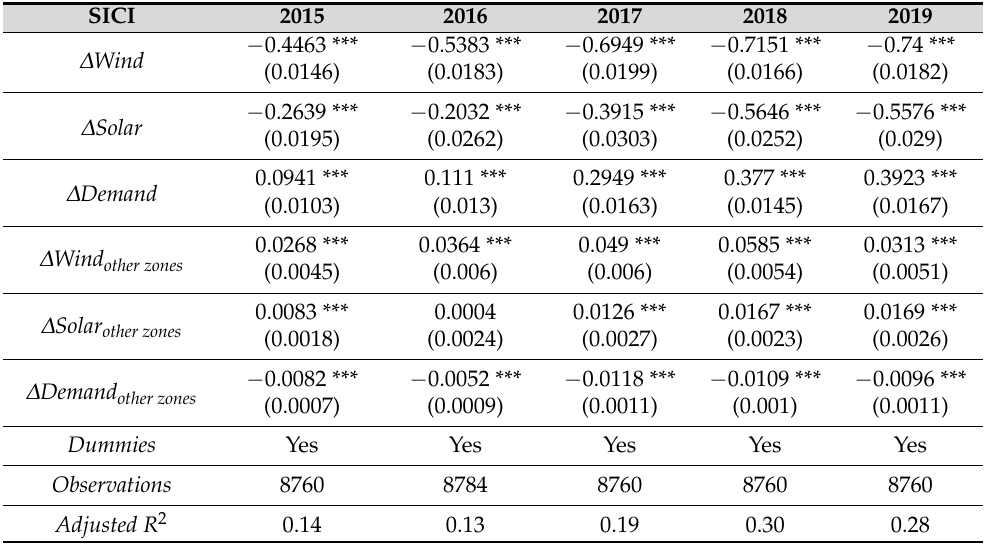
Table A11. OLS estimation of hourly changes in net input flow of SICI; results of Equation (1).